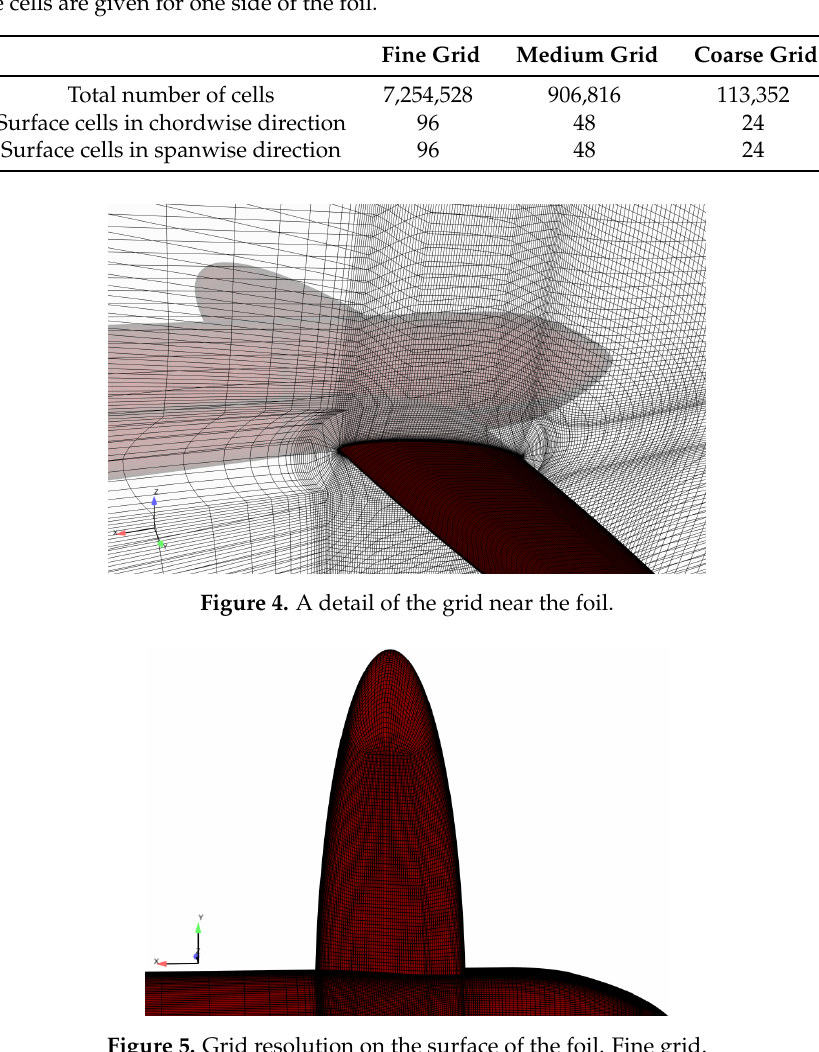
Figure 5. Grid resolution on the surface of the foil. Fine